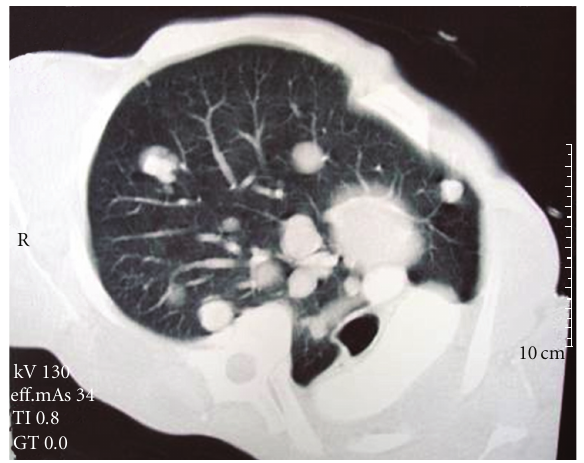
Figure 5: Innumerable metastatic nodules with involvement of thoracic